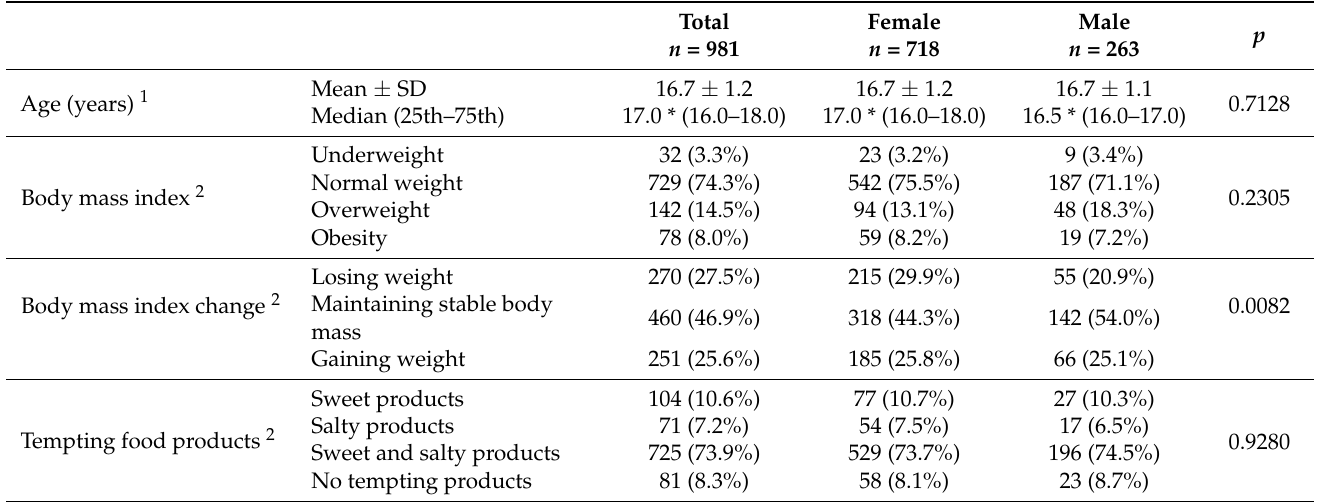
Table 1. The general characteristics of the sample studied within the Polish Adolescents’ COVID- 19 Experience (PLACE-19) Study for the self-regulation of eating behaviors ( n =